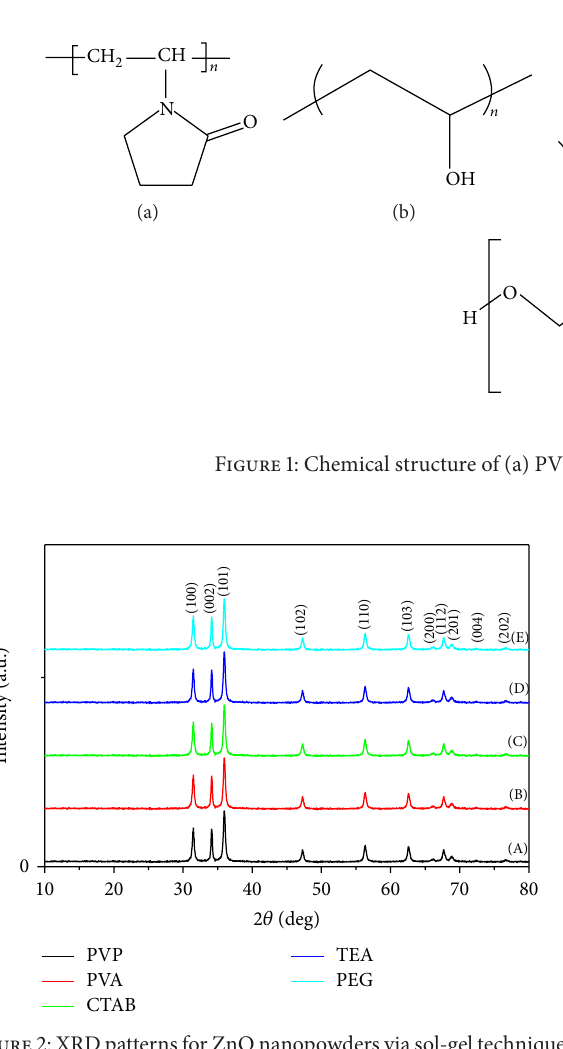
Figure 2: XRD patterns for ZnO nanopowders via sol-gel technique with different surfactant agents: (A) PVP, (B) PVA, (C) CTAB, (D) TEA, and (E)